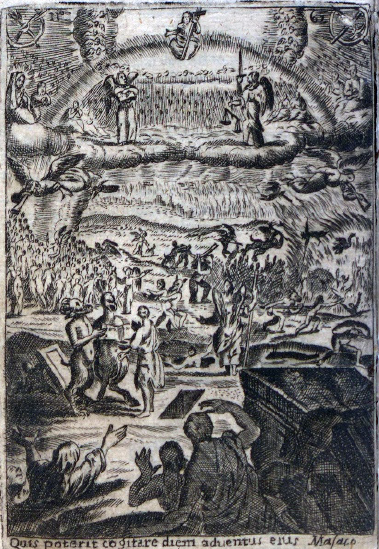
Figure 9. Anonymous. “ Quis poterit cogitare diem adventus eius . Malach. ” Juicio Final . The engraving is inserted between pp. 62 and 63. Sebastián Izquierdo, Práctica de los Ejercicios espirituales de Nuestro Padre San Ignacio . . . En Roma por el Varese, 1675.